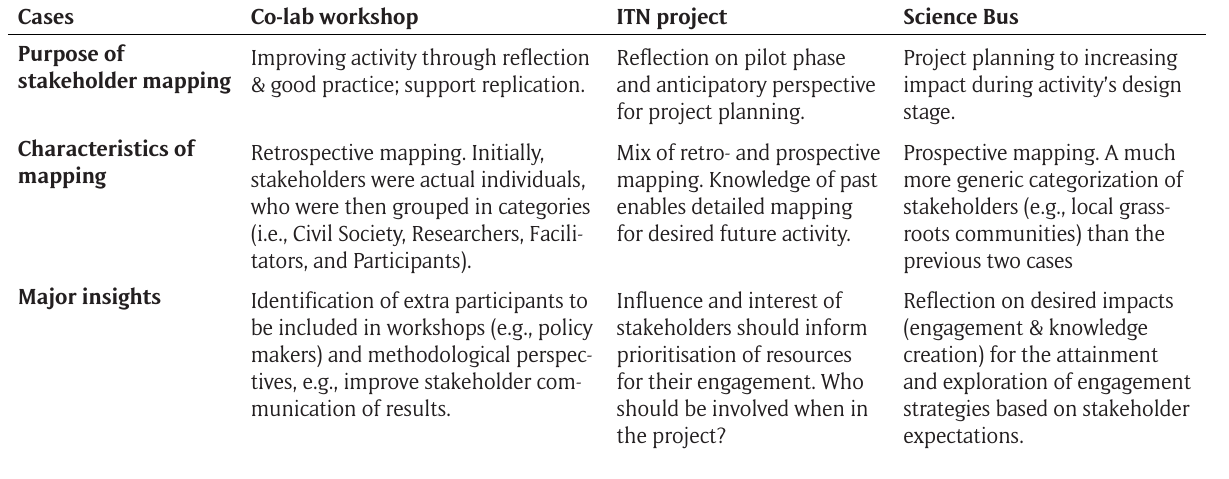
Table 2: Overview of purposes, characteristics of the mapping process, and major insights for three case studies.